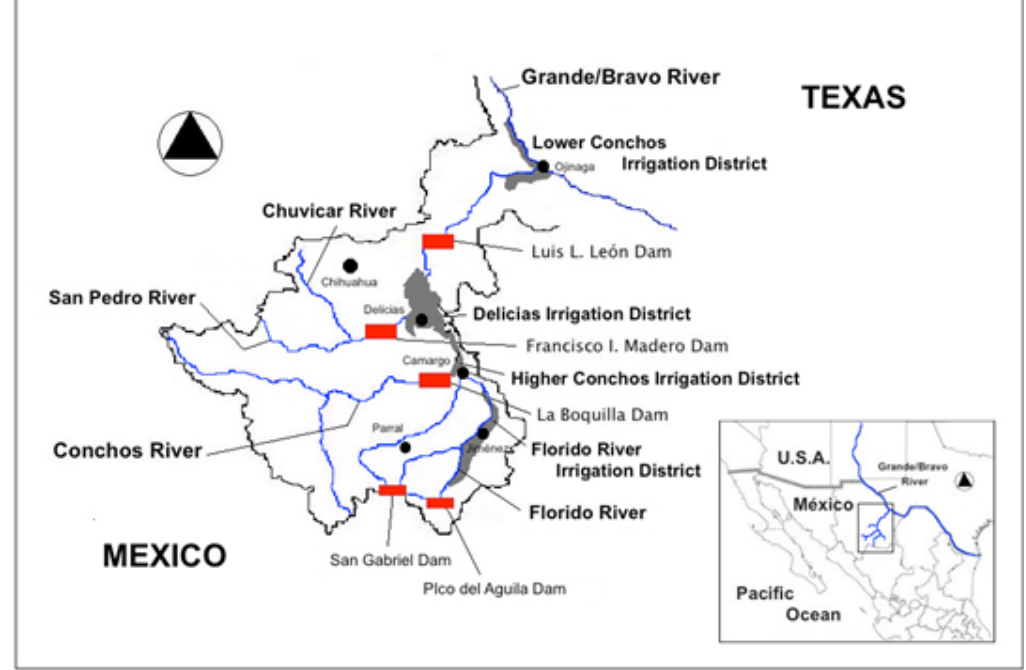
Figure 1. Rio Conchos Basin. Authors’ depiction based on SIG-Bravo